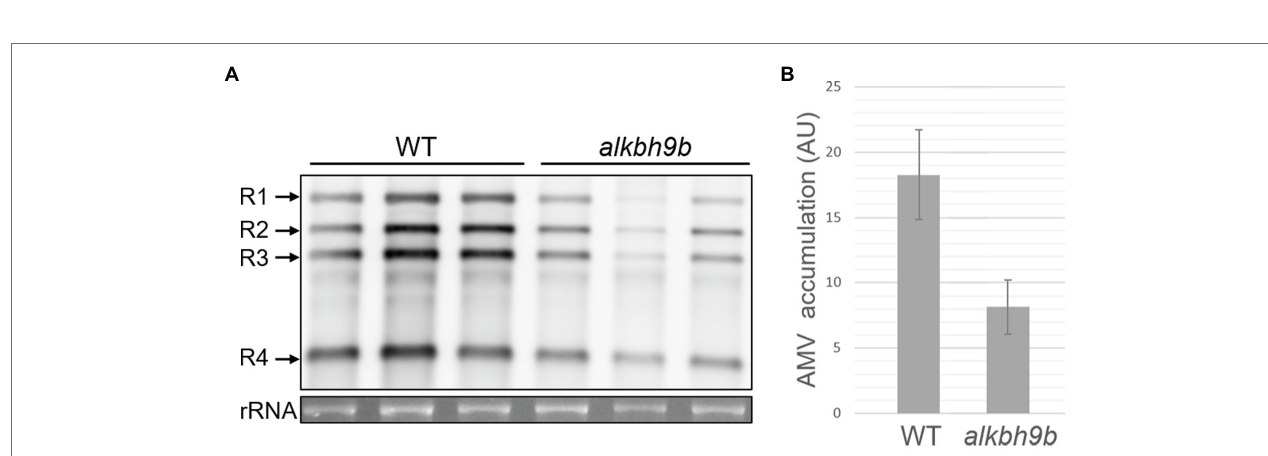
FIGURE 6 | AMV replication cycle is affected in alkbh9b protoplasts. (A) Representative northern blot of AMV-inoculated protoplasts isolated from WT and alkbh9b plants. Three biological replicates of each genotype are shown. Positions of the AMV RNAs are indicated on the left. Ethidium bromide staining of rRNA was used as RNA loading control. (B) Graphic showing the quantification of panel A. Error bars indicate standard